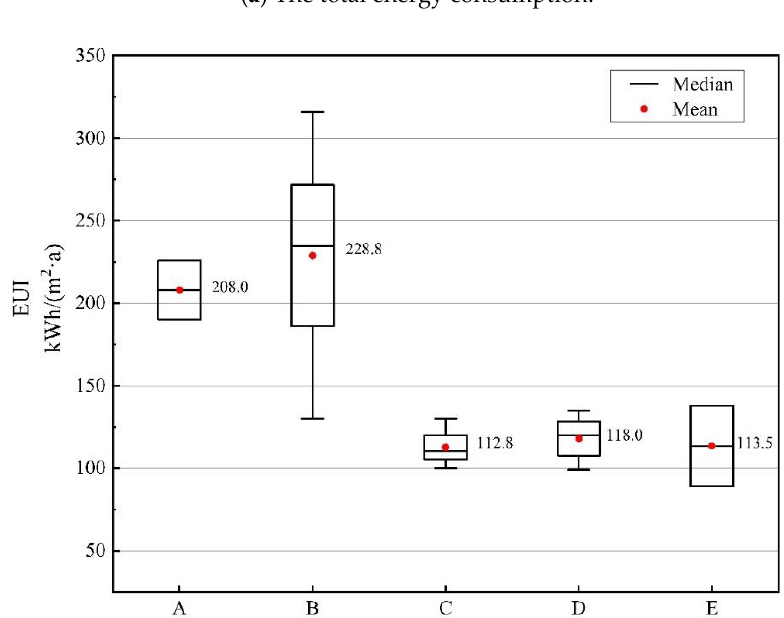
Figure 4. Box plot of EUI (energy use intensity) of high-speed railway stations.